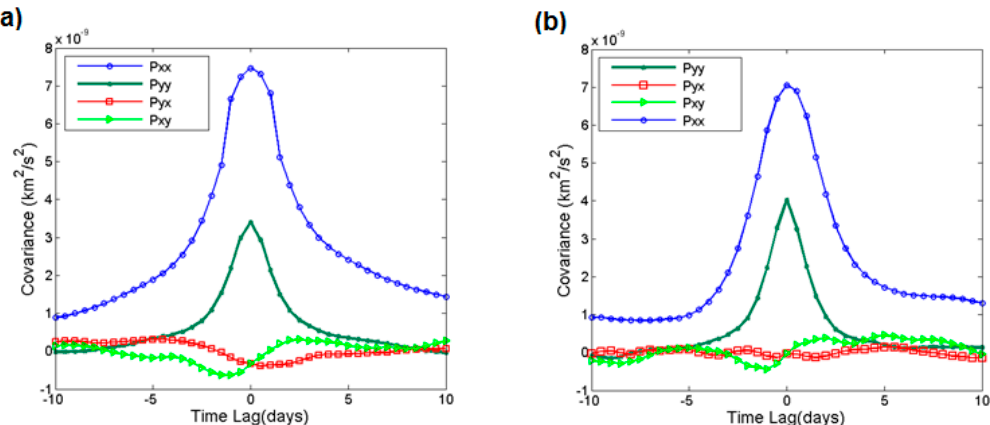
Figure 9. Lagrangian statistic (velocity covariance) calculated for the entire Adriatic basin after removal of the mean Eulerian circulation. Statistics are shown versus time lags ranging between − 10 and 10 days for numerical particles in 2007 ( a ) and 2008 ( b ). (Pxx and Pyy show along and across basin velocity covariance values respectively).